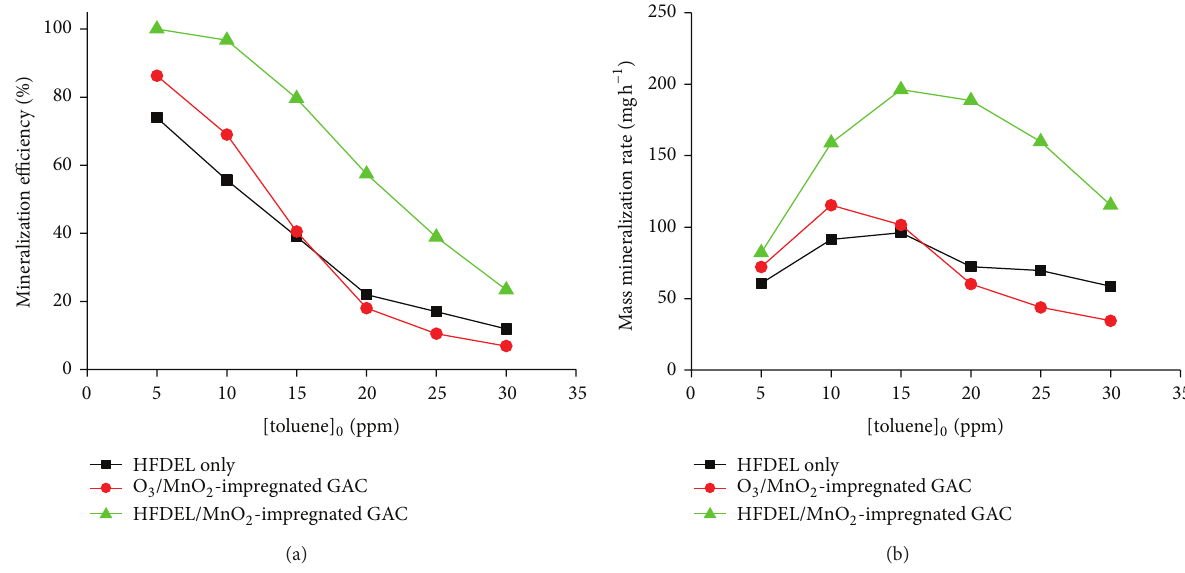
Figure 7: (a) Mineralization efficiency and (b) mass mineralization rate of toluene as a function of inlet toluene concentration by HFDEL only, O 3 /MnO 2 -impregnated GAC, and HFDEL/MnO 2 -impregnated GAC, respectively. Note that the inlet O 3 concentration in O 3 /MnO 2 - impregnated GAC is consistent with the photogenerated O 3 from